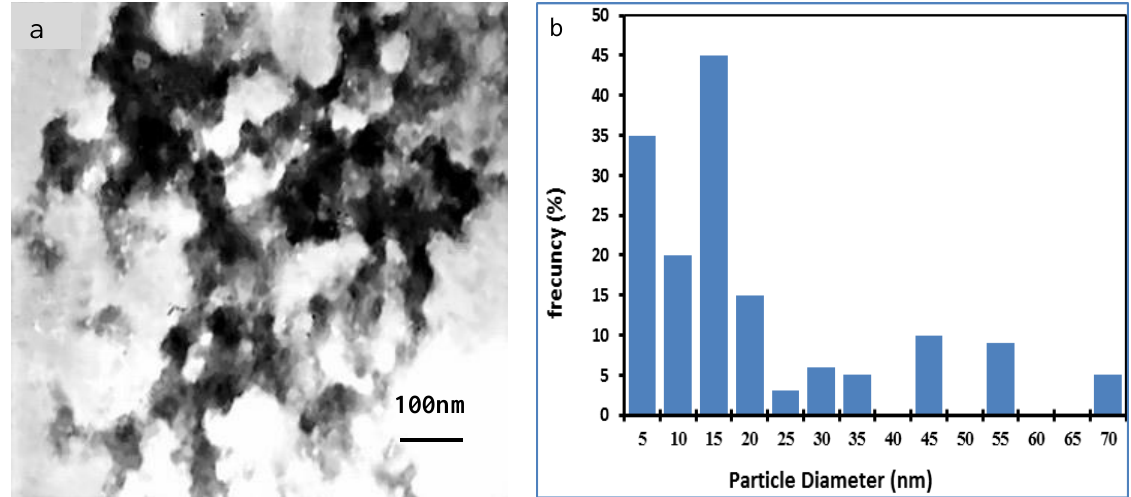
Fig.(10 a): TEM image of carbon nanoparticles obtained by laser ablation of graphite target at 80 mJ/pulse and 25 laser pulse in ethanol, b) The size distribution of